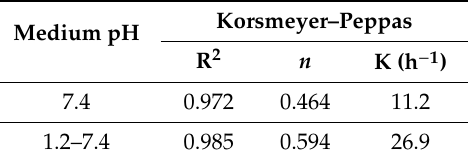
Table 1. Correlation values (R 2 ) and release exponent ( n ) of kinetic data analysis of chromone C27 release from PCL@C27 NPs in di ff erent